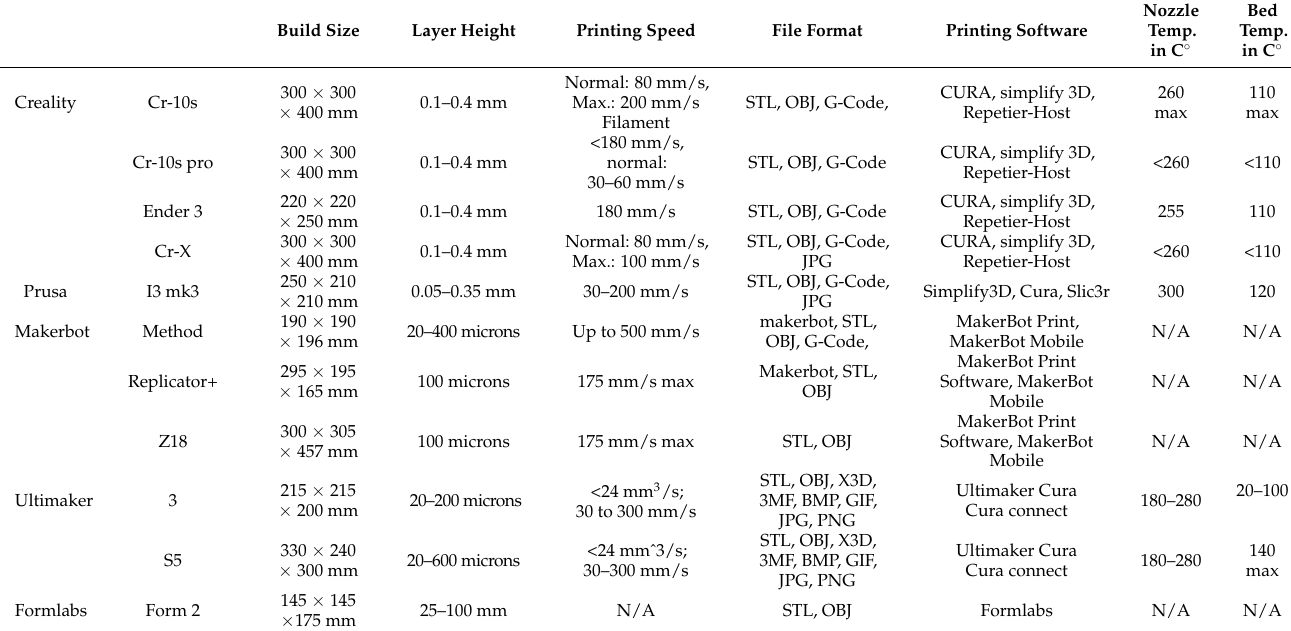
Table 12. Specifications of Desktop 3D